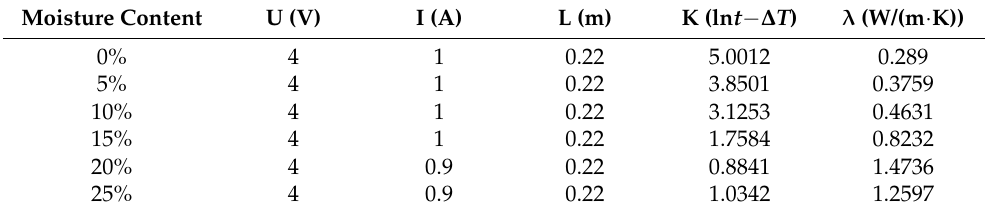
Table 1. Thermal conductivity of sediments with different water content.